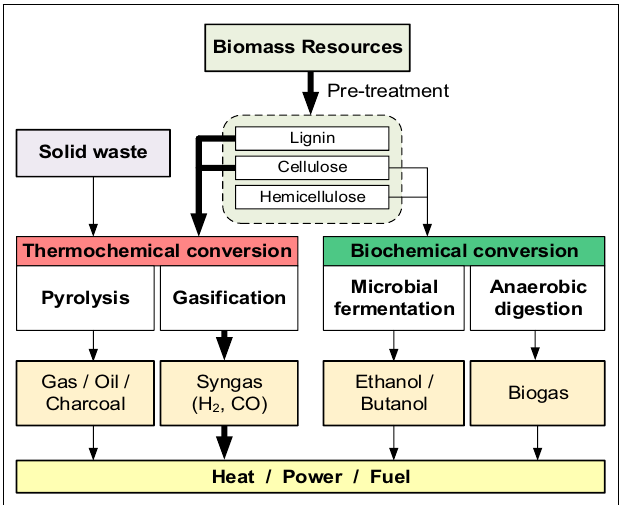
FIGURE 1 | Flow chart for biomass and solid waste conversion to energy paths